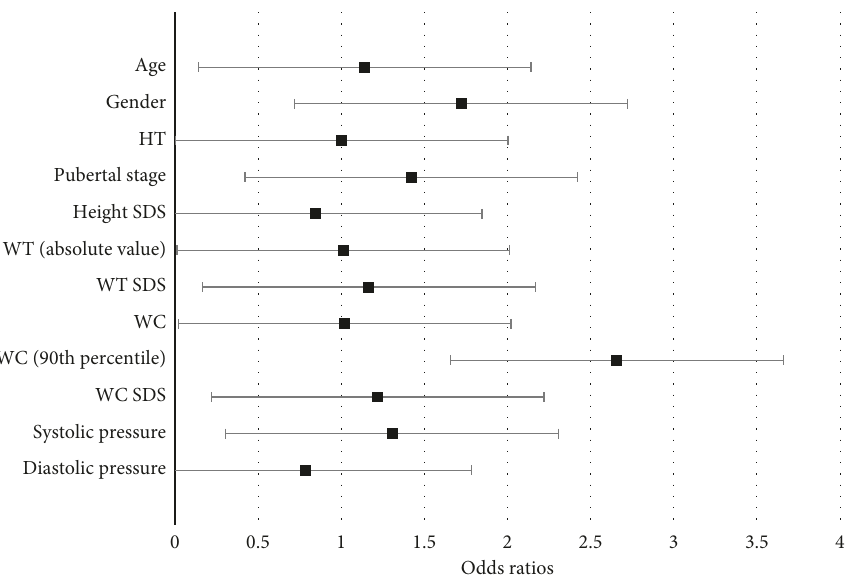
Figure 2: Bivariate logistic regressions between predictor variables and having elevated liver